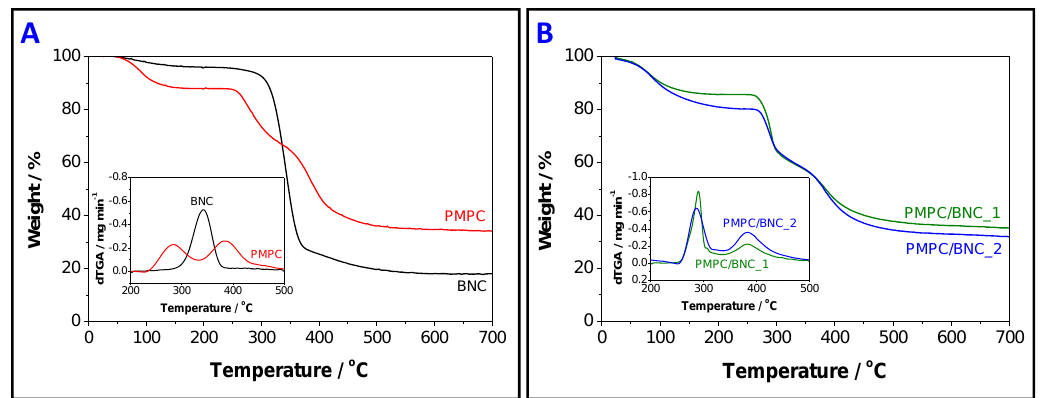
Figure 6. Thermograms of ( A ) cross-linked PMPC and neat BNC, and ( B ) membranes PMPC/BNC_1 and PMPC/BNC_2 under nitrogen atmosphere. The inset curves correspond to the derivative.